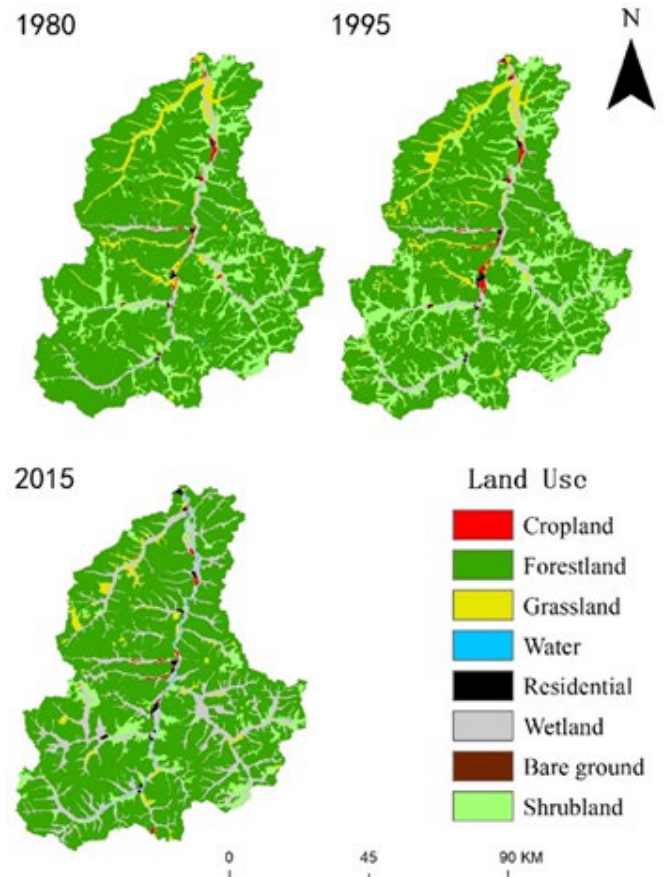
Figure 4. Land-use types in the Tahe River Basin in different years. Table 4. Land-use change in the Tahe River